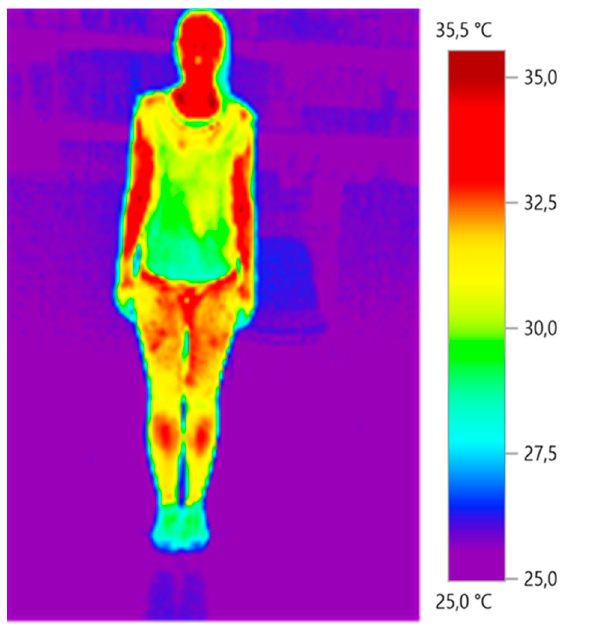
Figure 4. Exemplary recording with the thermal imaging camera.